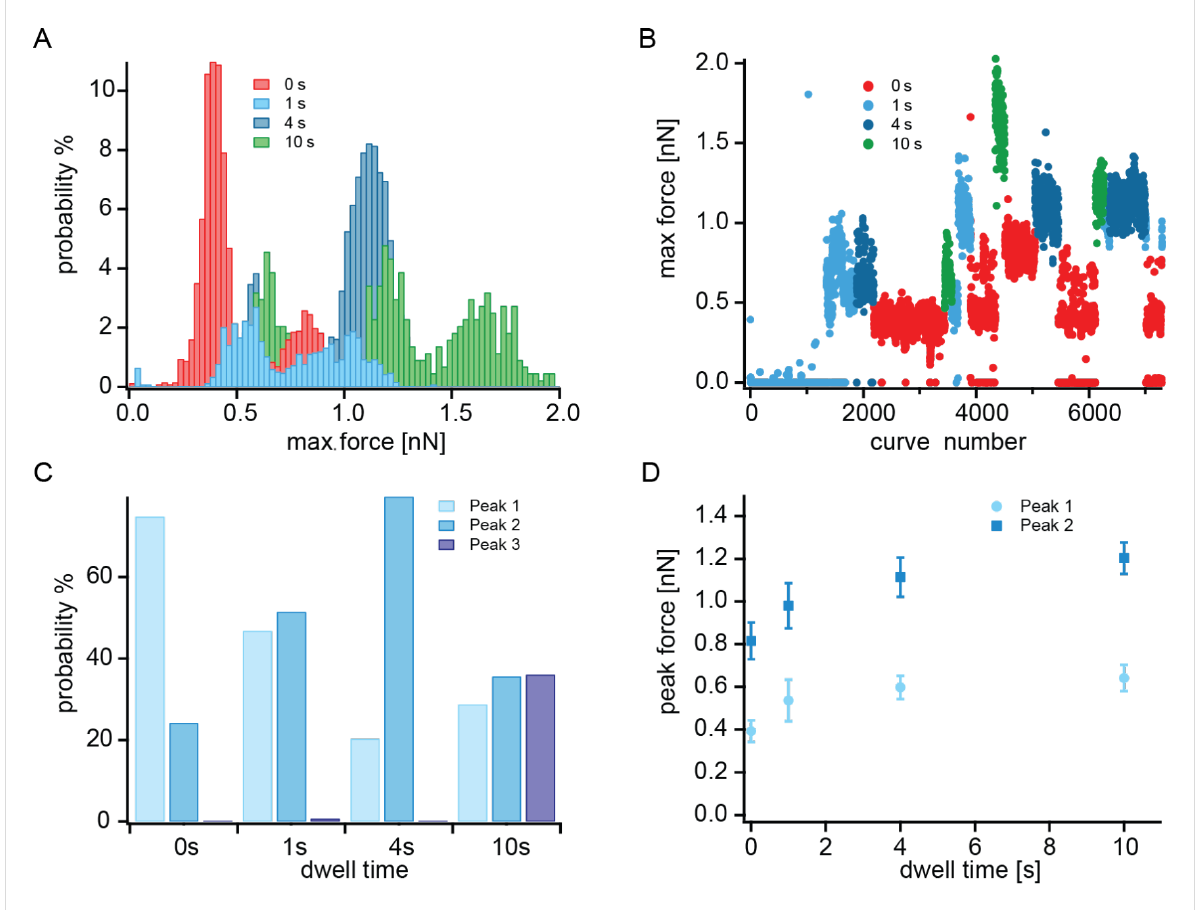
Figure 2: A) Maximum force histograms for the different dwell times indicated in the inset normalized to the number of measured force curves. B) Maximum force vs curve number is plotted to exclude bias due to the order of the measurement. C) Fraction of the number of force peaks belonging to poly- and/or multivalent interactions for the different surface contact times (see main text for details). D) Peak values of the maximum force histograms for the first and second peak are plotted against the dwell time. The standard deviation of the Gaussian fit is given as the